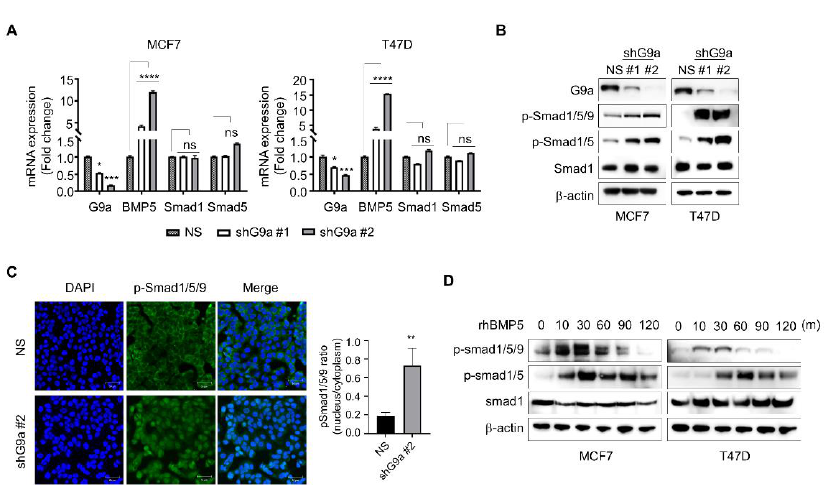
Figure 5. G9a knockdown facilitates Smad protein phosphorylation via BMP5 activation. ( A , B ) G9a- knockdown-induced increase in BMP5 expression had no effect on the total level of either Smad1 or Smad5. G9a knockdown increased phosphorylation of Smad1/5/9. ( C ) ICC demonstrated that nu- clear translocation of pSmad1/5/9 was increased in G9a-depleted MCF7 cells. ( D ) Similar tendency was found after treatment of recombinant BMP5. p values were calculated using ANOVA. * p < 0.05, ** p < 0.01, *** p < 0.001, **** p < 0.0001, ns = not significant.